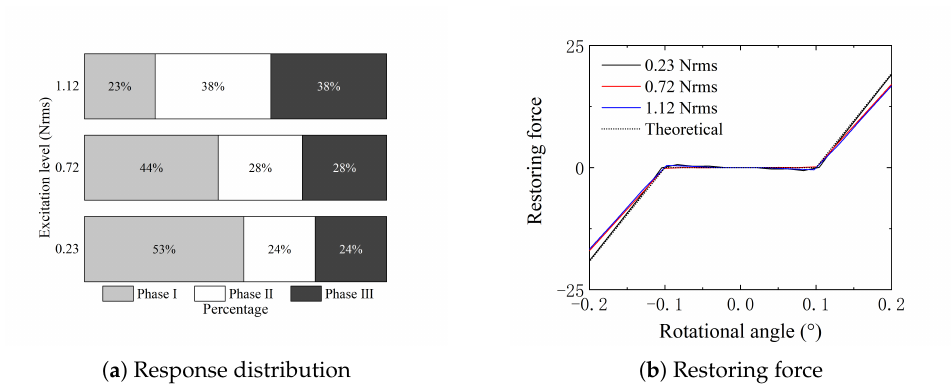
Figure 12. The nonlinear identification of different excitation